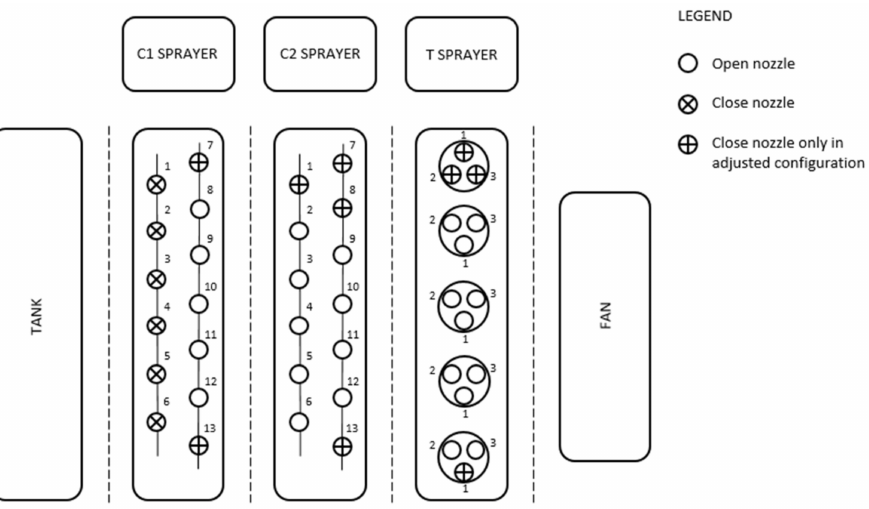
Figure 4. Active nozzles in the applications with adjustment to the vegetation in the three